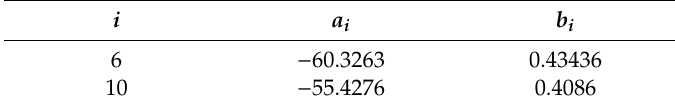
Table 1. Determination of the constants a i and b i for the di ff erent sensor